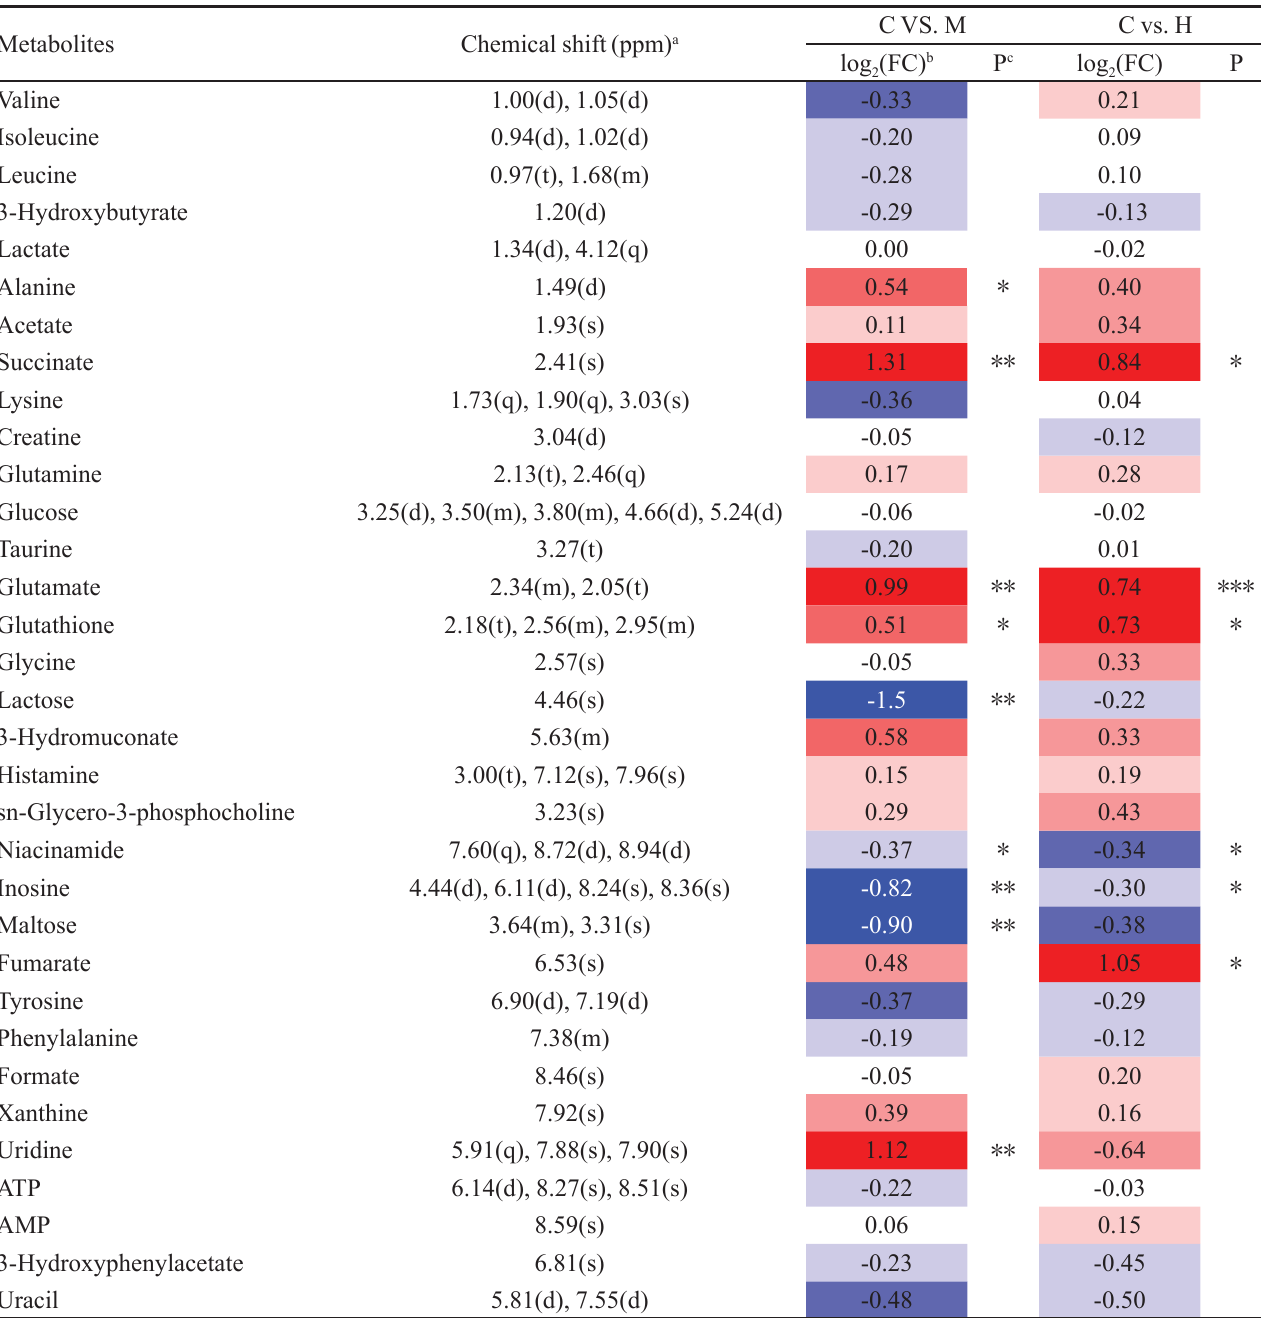
TABLE II - Identified metabolites in the kidney from different groups with log (d), triplet (t), quartets (q), multiplets (m). b Color coded according to the log2(FC), red represents increased and blue represents decreased concentrations in glyphosate exposed groups. Color